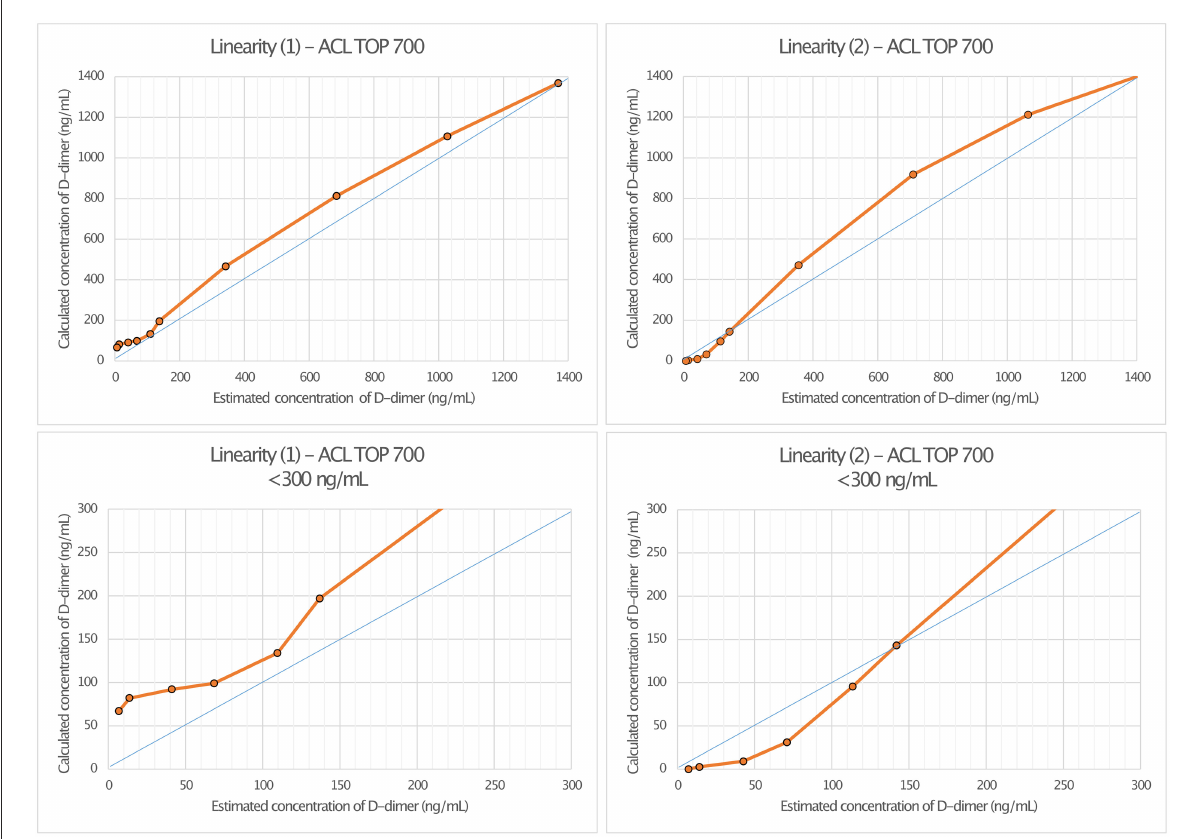
FIGURE3 Linearity assessment of D-dimer measurement in cerebrospinal fluid (CSF) using HemosIL HS 500 reagent latex-enhanced immunoassay. The measurement was performed on two different ACL TOP 700 analyzers [Linearity (1) and Linearity